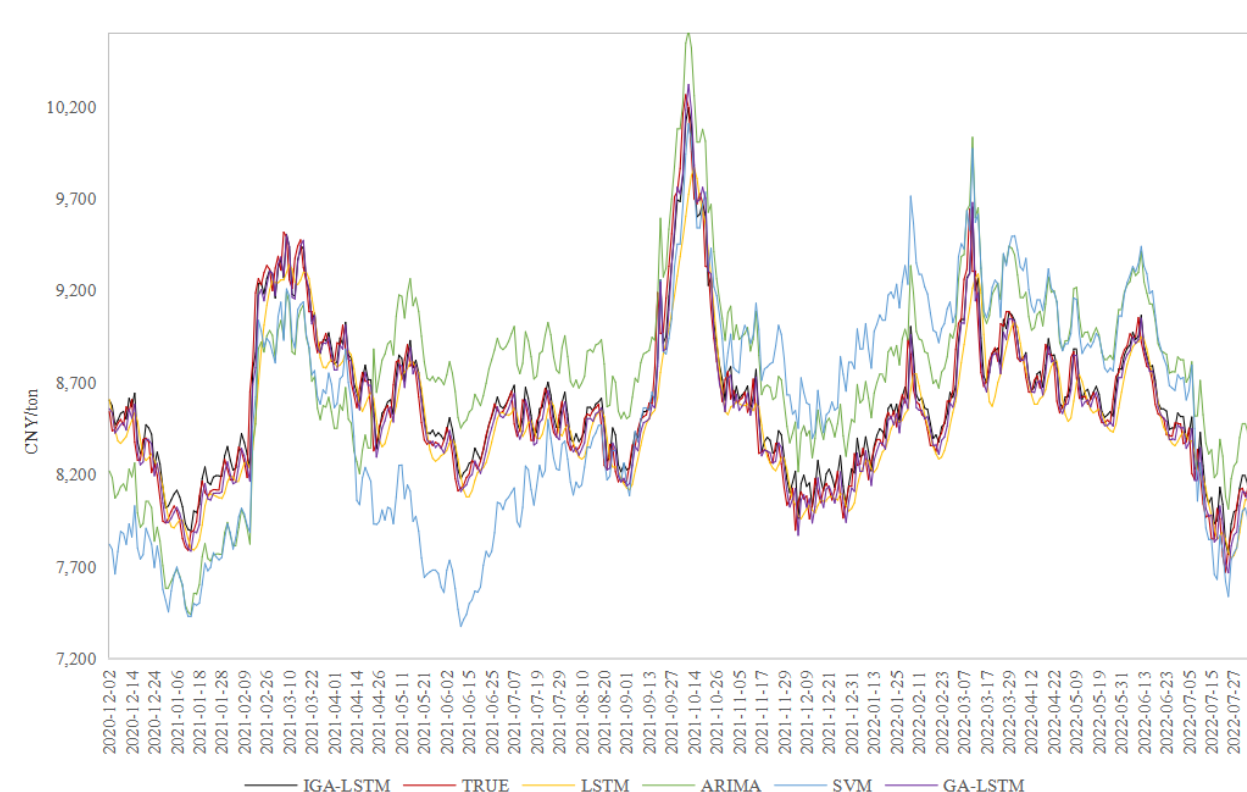
Figure 5. PP futures price forecast